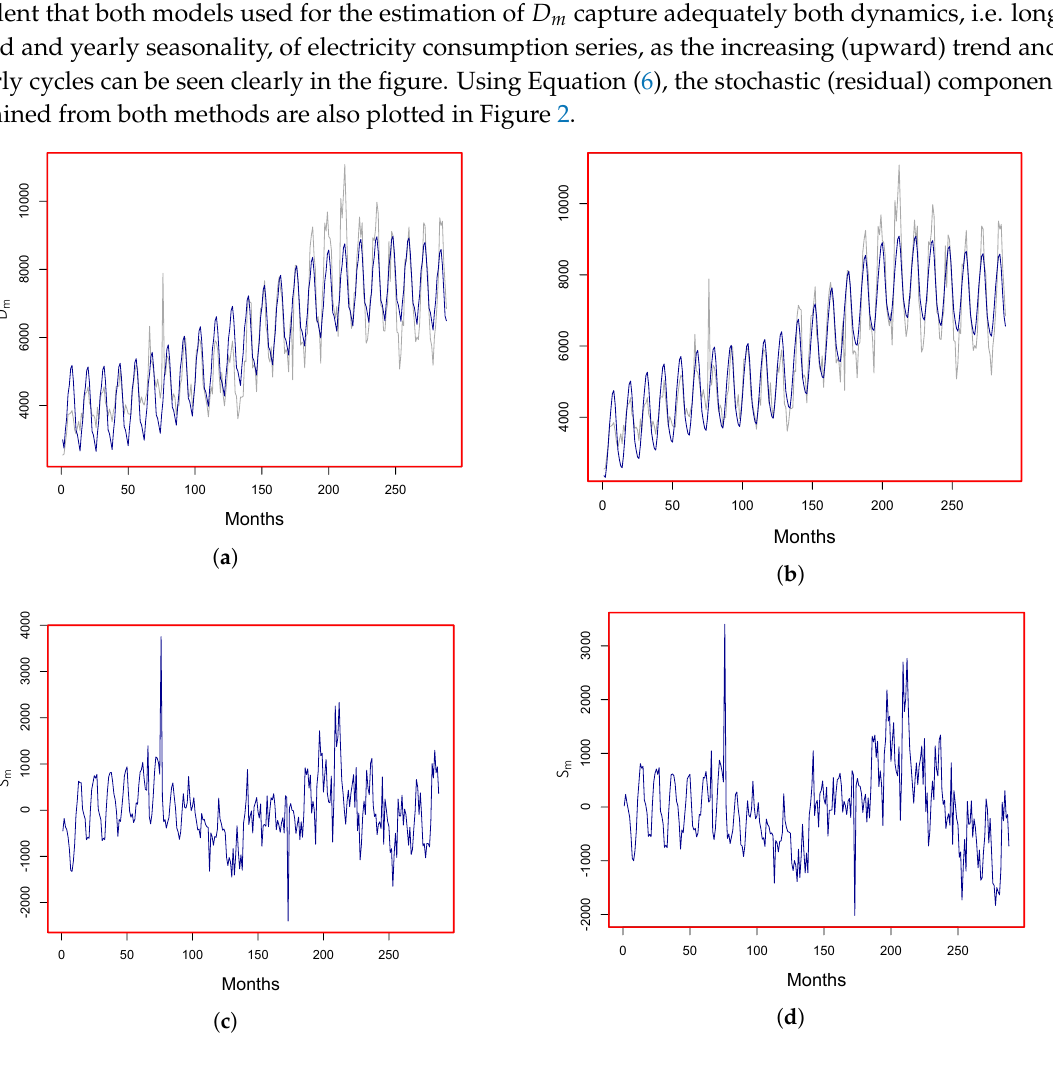
Figure 2. Pakistan electricity consumption series with superimposed fitted deterministic component ( D m ) for parametric ( a ) and nonparametric ( b ) methods, and stochastic component ( S m ) from parametric case ( c ) and from nonparametric case ( d